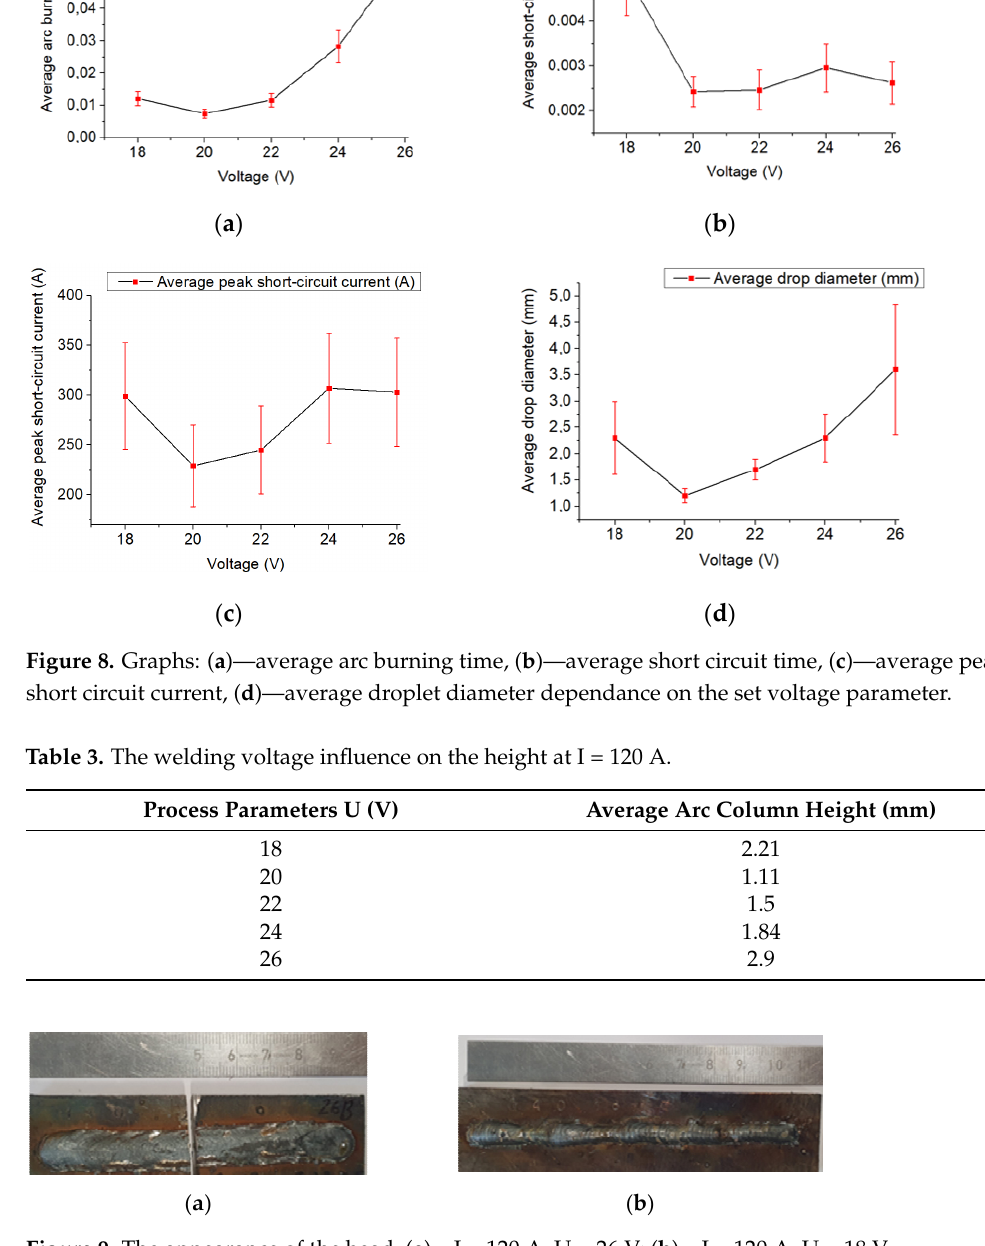
Figure 9. The appearance of the bead, ( a )—I = 120 A, U = 26 V; ( b )—I = 120 A, U = 18 V.